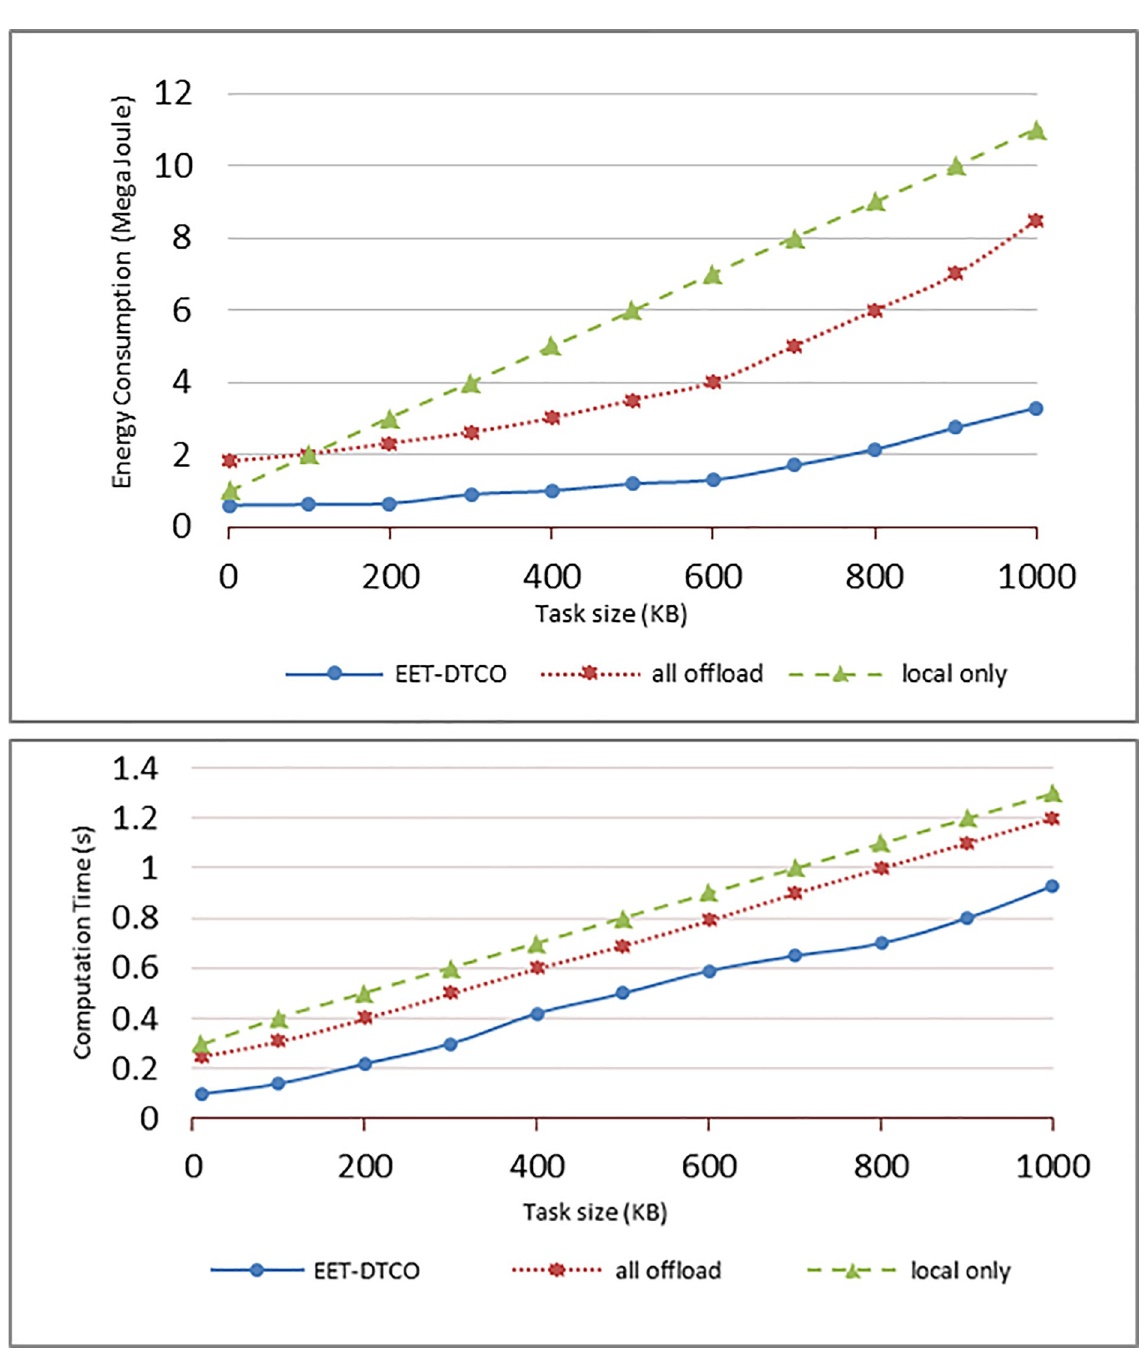
Fig 7. Impact of task size on (a) energy consumption and (b) computation